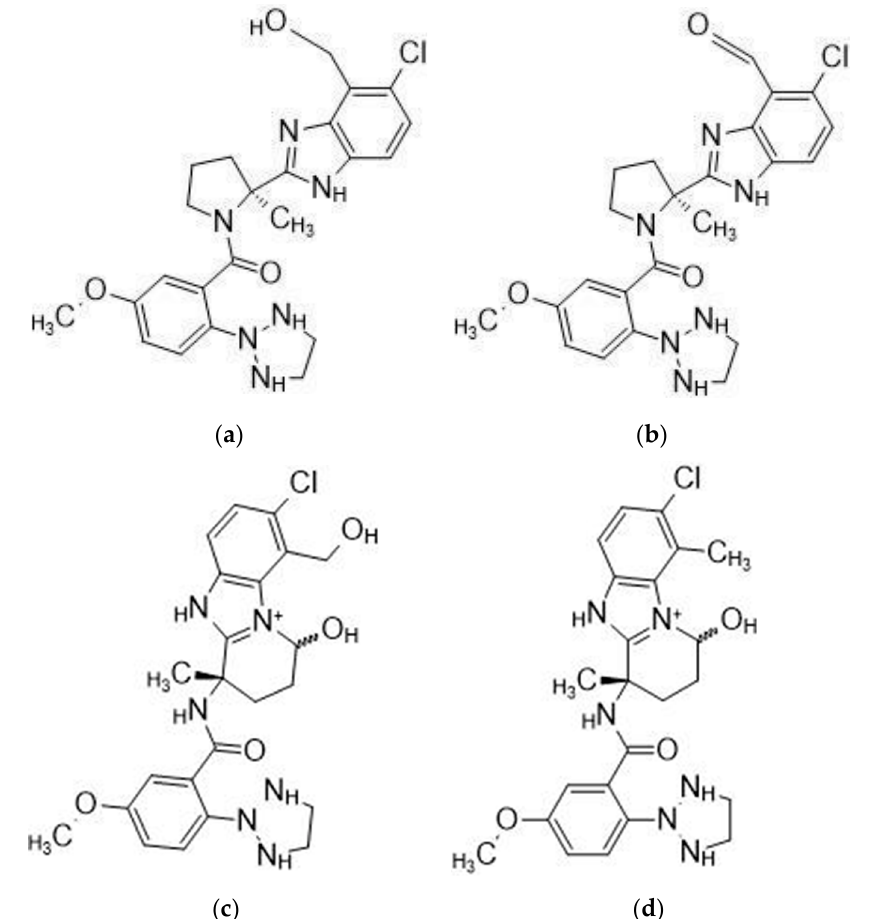
Figure 2. Major daridorexant metabolites. ( a ) is the starting point for ( b ), which is formed by oxidizing the primary alcohol to the corresponding aldehyde, then ( c ) is formed by an oxidative rearrangement of metabolite ( d ) [20].